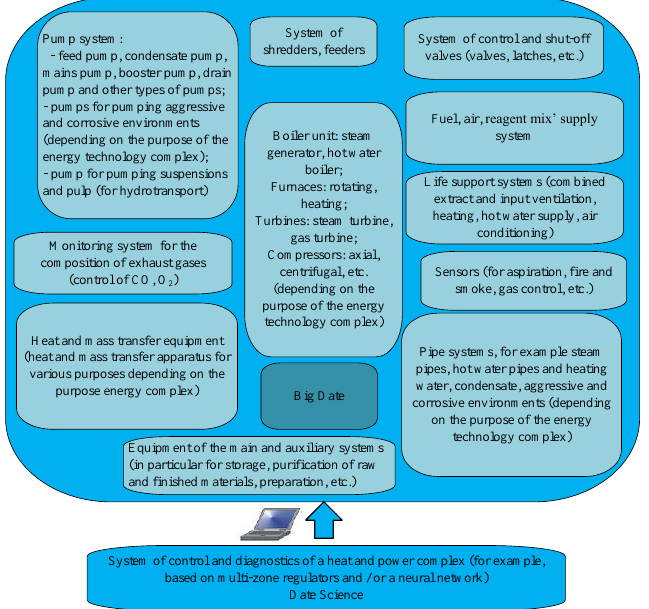
Figure 2. Generalized structure of energy technological complexes with special management func- tions for quality of management in the sustainable development